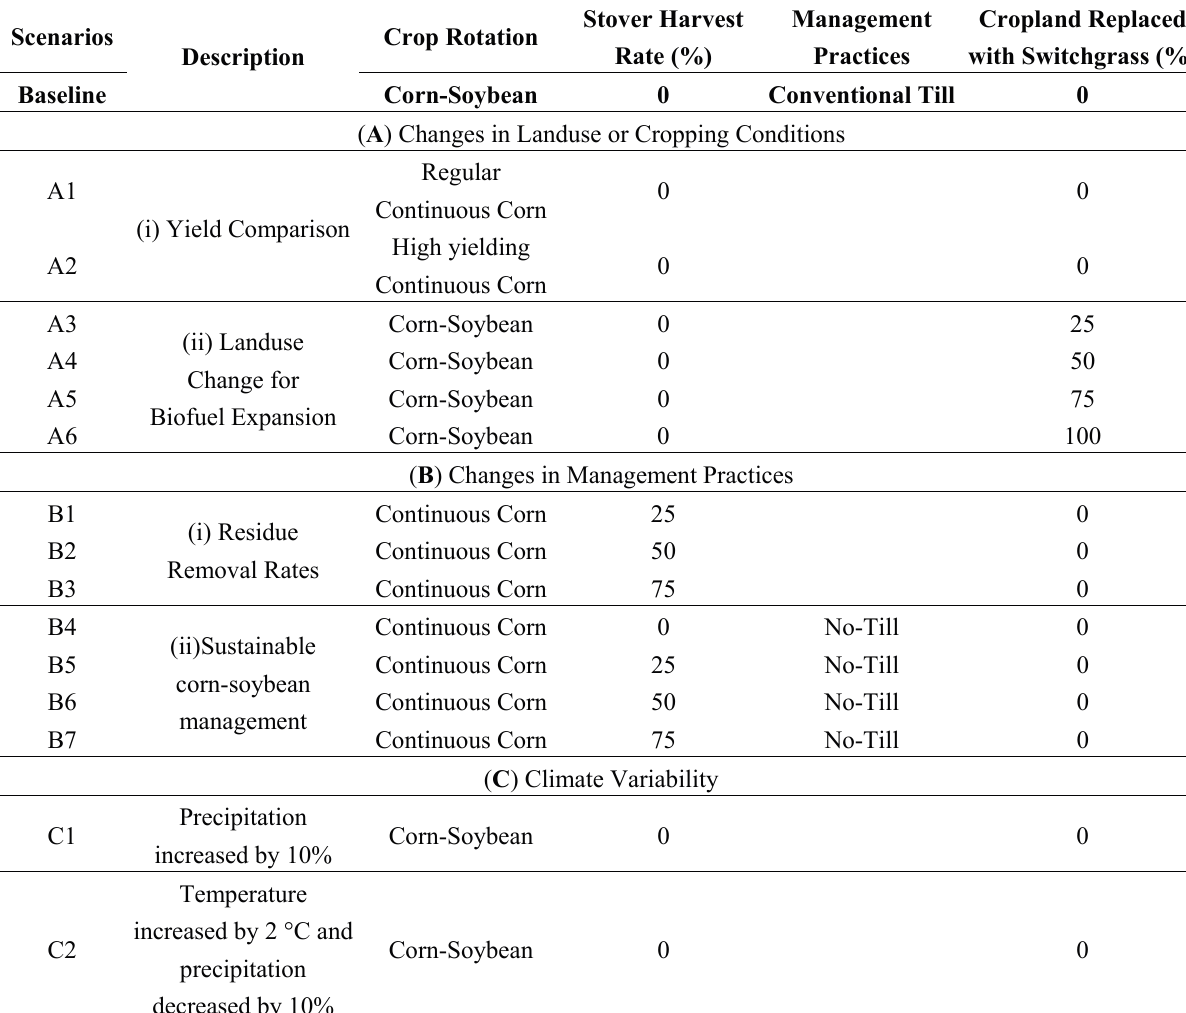
Table 1. Scenarios for biofuel